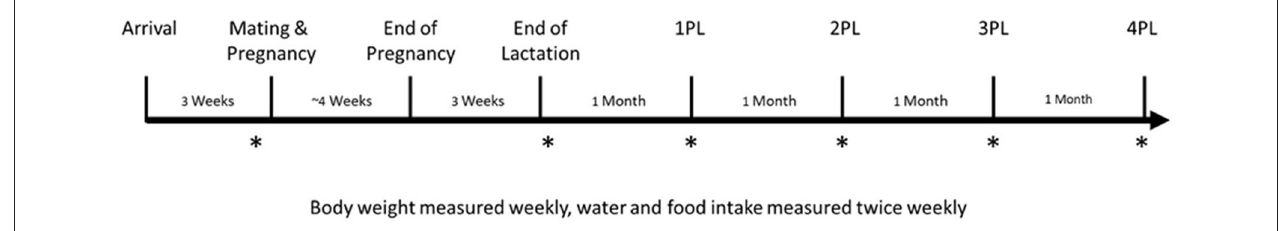
FIGURE 1 | Study design. Female Sprague-Dawley rats arrived at 5 weeks of age and were randomized to either a PREG TEA, PREG CON, or NONPREG CON group ( n = 14) following 1 week of acclimatization. Rats were then further acclimatized for another 2 weeks to their respective groups. Following acclimatization, females were mated for a duration of 2 estrous cycles (5 days per cycle). In vivo scans for measurement of bone structure and quantity of the right proximal tibia using µ CT are denoted by an asterisk (*) and were completed at pre-pregnancy (Pre), immediately after lactation (PL), and 1, 2, 3, and 4 months post-lactation (1PL, 2PL, 3PL, 4 PL). Rats from NONPREG CON were scanned at the same time points to provide an age-matched control. Necropsy and organ collection occurred approximately 1 week following the 4PL